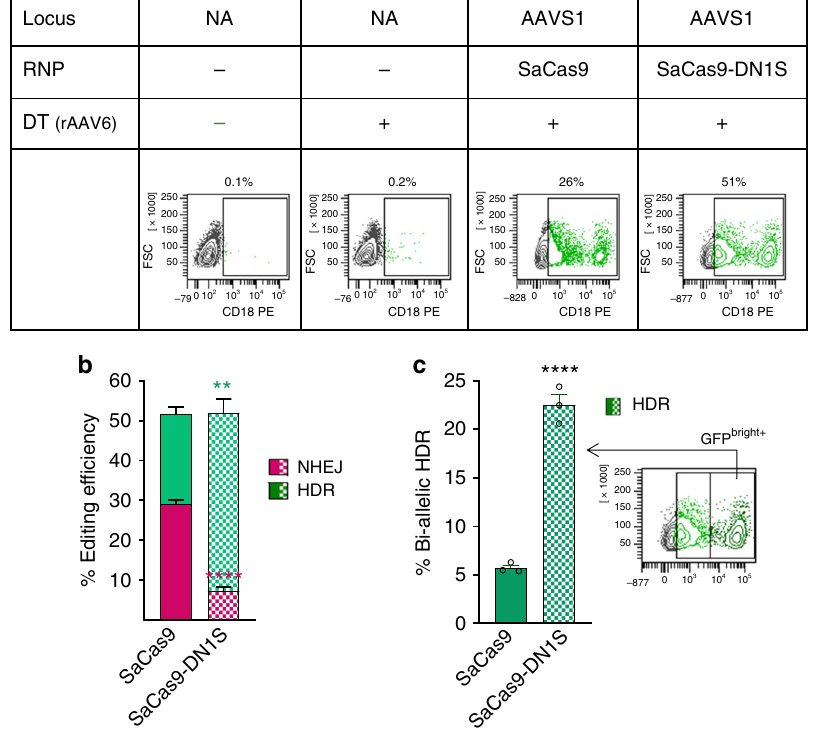
Fig. 4 CD18 insertion at the AAVS1 locus in LAD patient-derived B lymphocytes. a Representative fl ow cytometry plots of EBV-immortalized LAD patient B- lymphocytes, electroporated for targeted integration of CD18 at the AAVS1 locus, showing fractions of HDR + cells. Donor template (DT) was delivered via rAAV6. b Stacked bar plots showing quanti fi cation of HDR ef fi ciency by fl ow cytometry and NHEJ ef fi ciency by TIDE assay of SaCas9 or SaCas9-DN1S with AAVS1-CD18 rAAV6 donor template. The data are presented as the mean ±SEM of three independent electroporations. Statistics: unpaired t tests, one tailed comparing HDR (green asterisks) or NHEJ (magenta asterisks): ** p < 0.01, **** p < 0.0001. c Relative frequencies of bi-allelic HDR detected by sorting the GFP dim + and GFP bright + cell populations as gated, based on the density and MFI of CD18 by fl ow cytometry. The sorted GFP bright + population was con fi rmed to be bi-allelic HDR by PCR (shown in Supplementary Fig. 14). The data are presented as the mean ±SEM of three independent electroporations. Black circles indicate individual data points. Statistics: unpaired t- tests, one tailed: **** p < 0.0001. Source data is available in Source Data fi